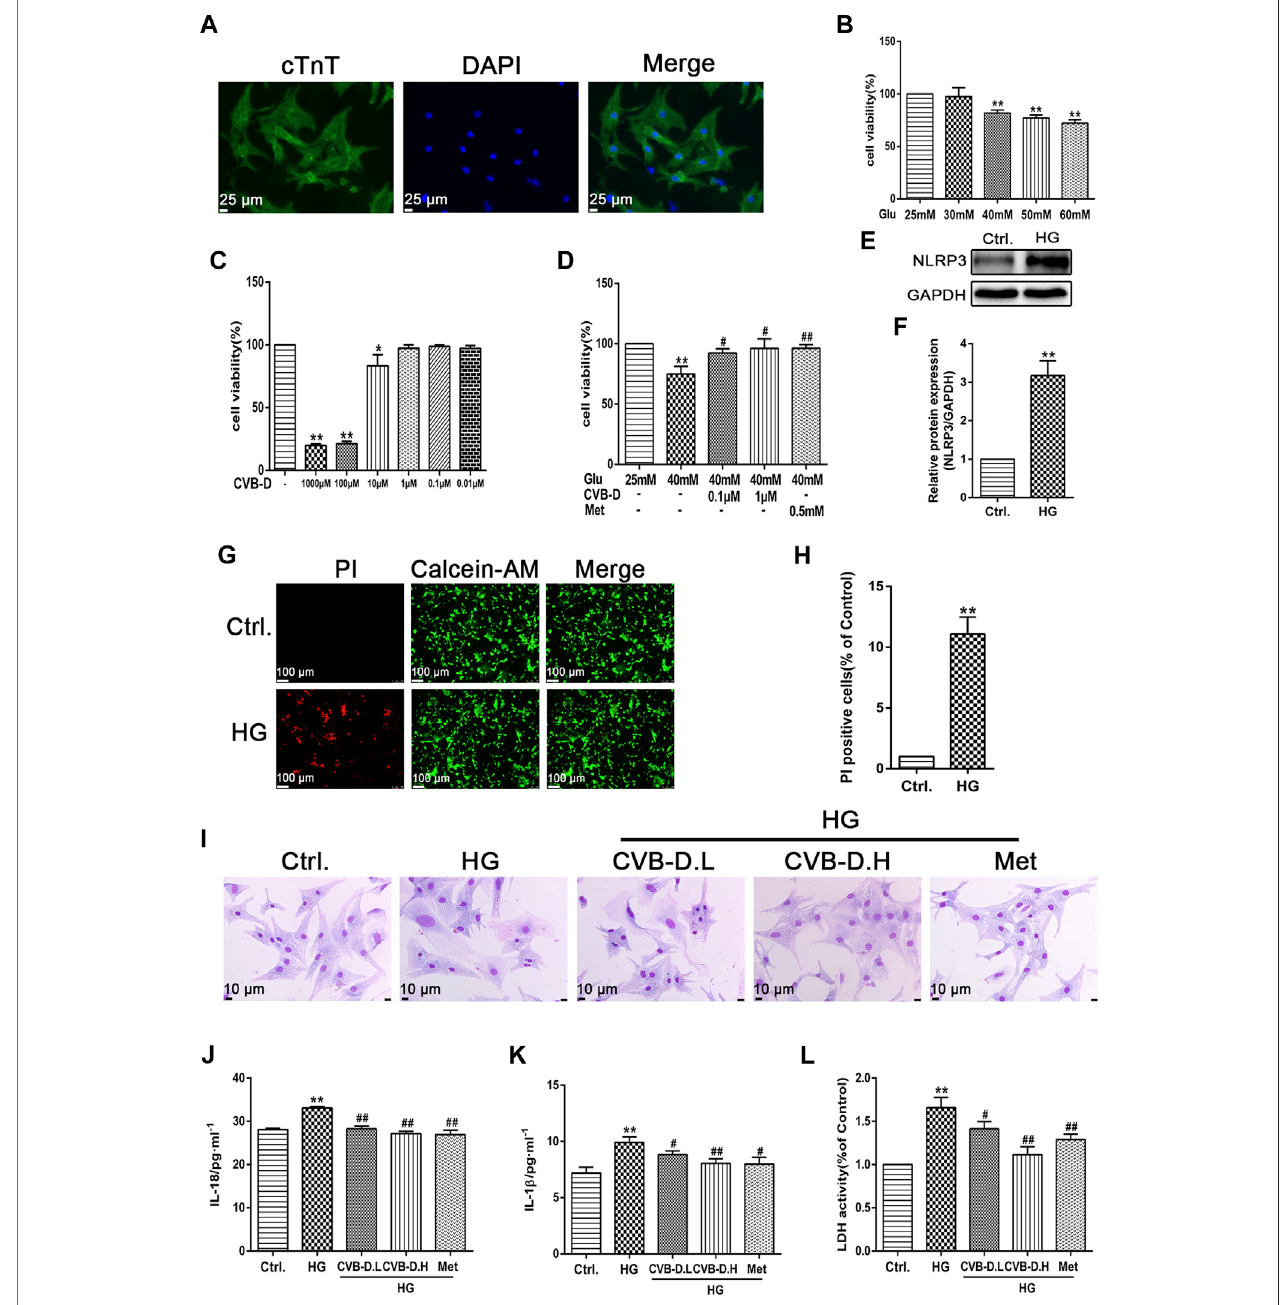
FIGURE 5 | CVB-D improves the PNRCMs (primary neonatal rat cardiomyocytes) injury induced by HG (high glucose). (A) Immuno fl uorescence was used to identifythepurityofPNRCMs. (B – D) TheeffectofCVB-DonthedecreasedviabilityofPNRCMsinducedbyHGwasdetectedbyMTTassay. (E,F) Westernblottingwas used to determine the effect of HG on NLRP3 expression in PNRCMs. (G,H) Calcein-AM/PI staining was used to observe cardiomyocyte pyroptosis caused by HG. (I) EffectsofCVB-DonpathologicalchangesofPNRCMsinducedbyHGwereobservedbyGiemsastaining. (J – L) In fl uenceofCVB-DonthecontentsofIL-18,IL-1 β and LDH inthesupernatantofPNRCMs culture medium weredetectedbyELISAand LDHkits. Thedataarepresentedasthemean±SEM( n =3), * p < 0.05, ** p < 0.01 versus the control group; # p < 0.05, ## p < 0.01 versus the model group.